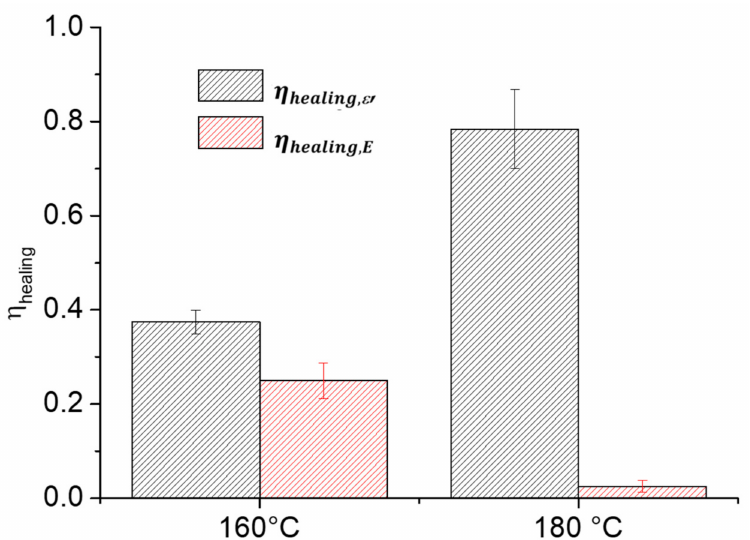
Figure 8. Healing e ffi ciency at di ff erent healing temperatures for nanofilled toughened PBT.